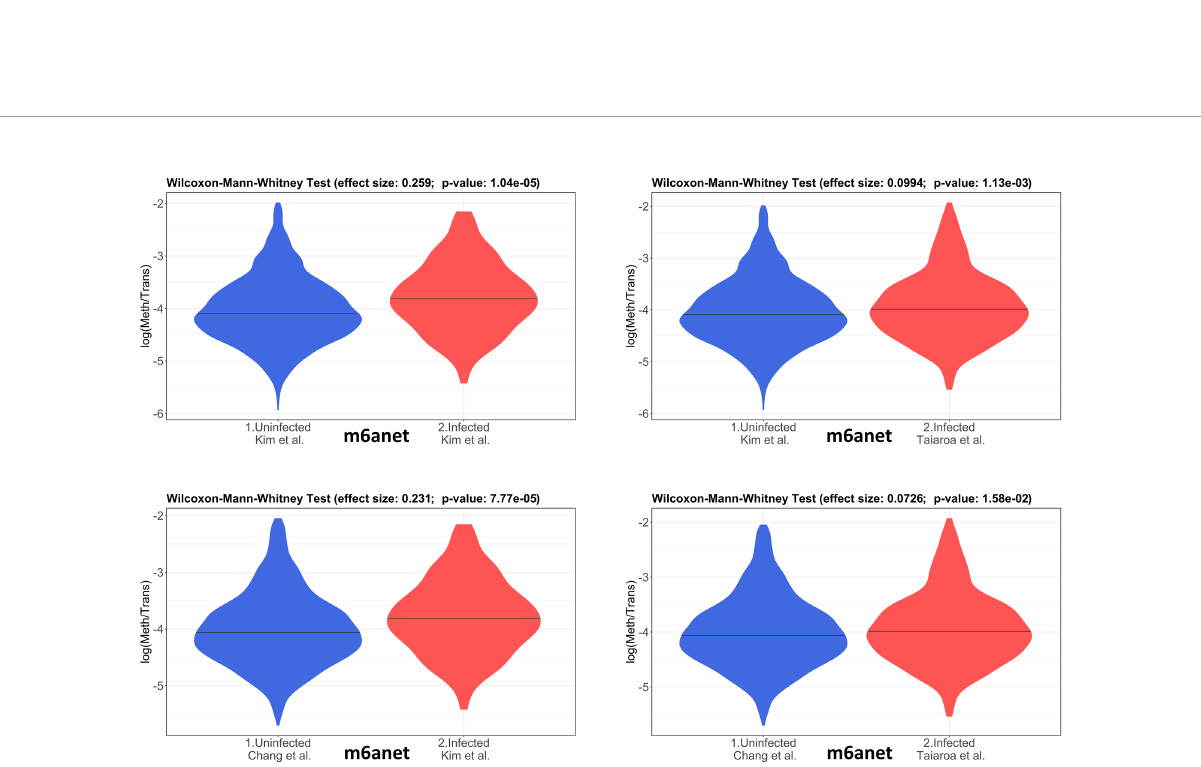
FIGURE 2 Violin plots of the distributions of differentially methylated transcripts in Uninfected and Infected Vero cell datasets using program m6anet. The areas indicate the data distribution of each sample and the horizontal bars in the middle of the areas indicate the Medians. The Effect size and p -values are as obtained by the Wilcoxon-Mann-Whitney test as described in Material and Methods. The abscissas idicate the samples and the ordinates indicate the quantity S =log(methylated sites/transcript), which is the logarithm with base 10 of the proportion of methylated sites per transcript, for all transcript types in each